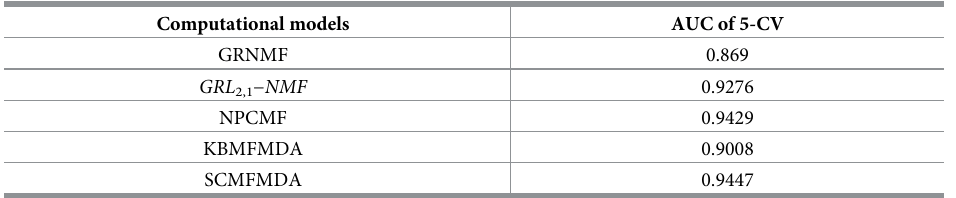
Table 1. Comparisons between SCMFMDA and other MF-based